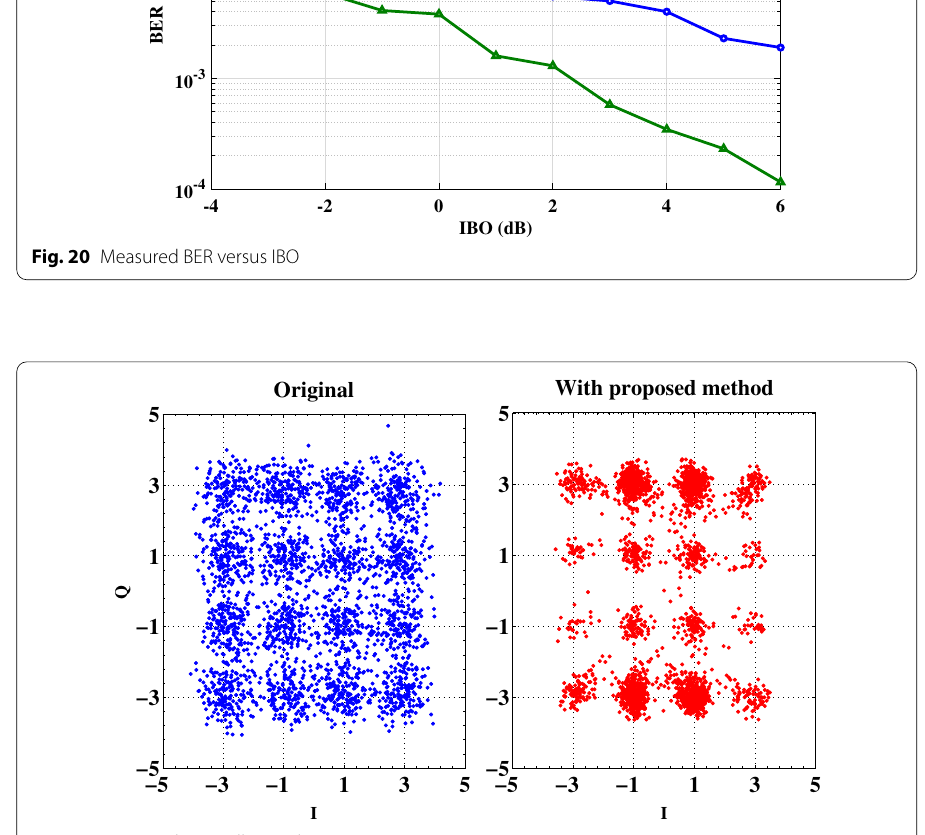
Fig. 21 Measured constellation